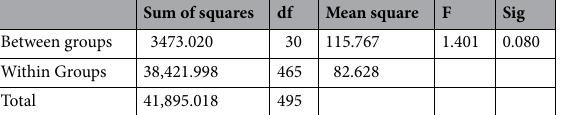
Sum of squares df